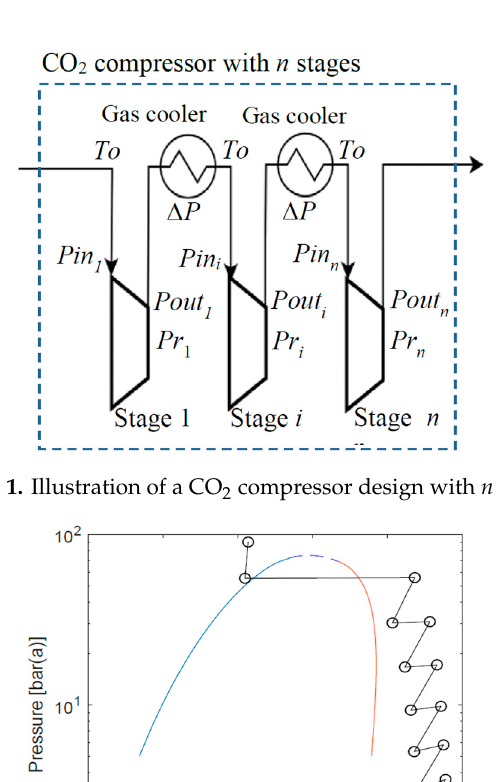
Figure 2. Illustration of a conventional nine-stage compressor in a pressure-enthalpy diagram.